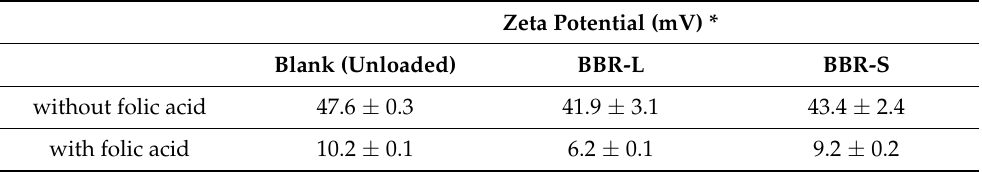
Table 1. Zeta potential values of the NPs and of the same NPs functionalized with folic acid.